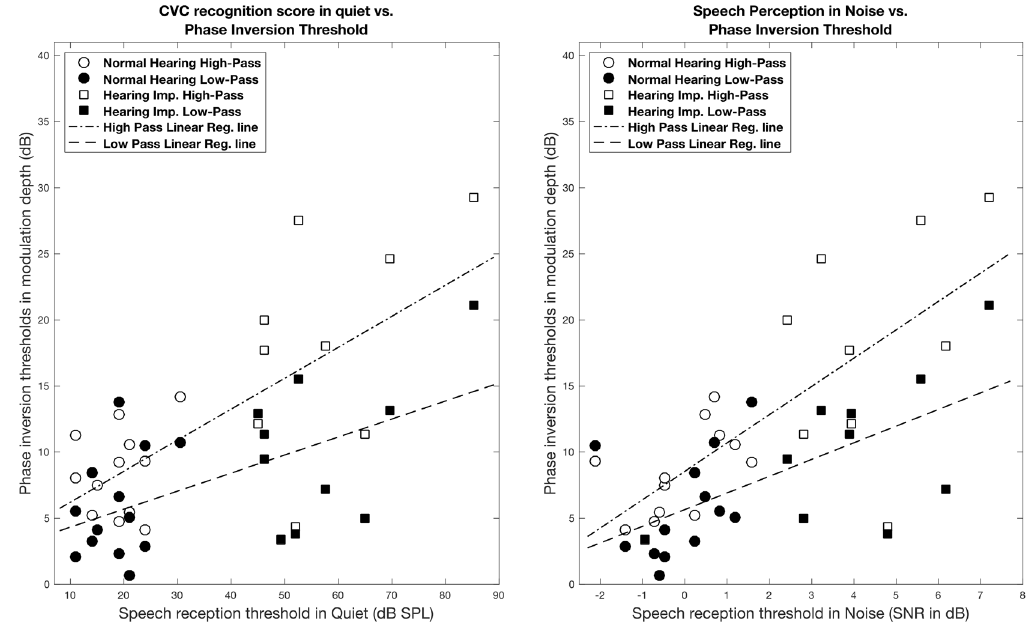
Figure 1. Correlation between the PID thresholds (dB re 100% modulation depth) and speech perception performance. The left panel shows PID as a function of speech reception in quiet. The right panel shows PID as a function of speech perception in